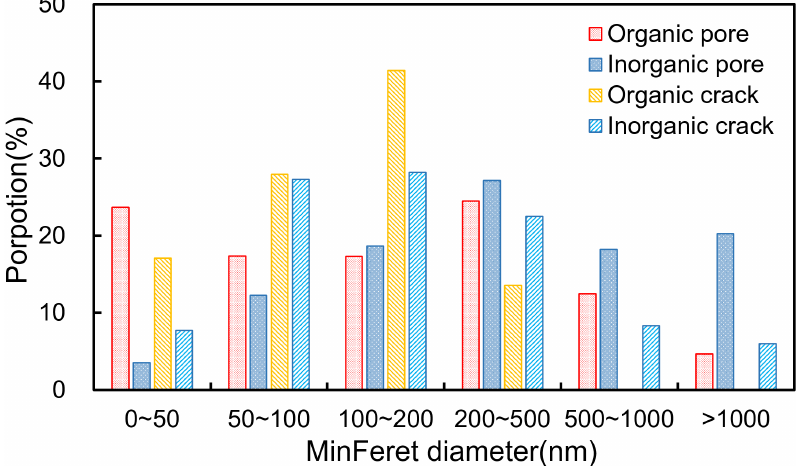
Figure 6. Pore size distributions of four pore Figure6. Pore size distributions of four pore types.